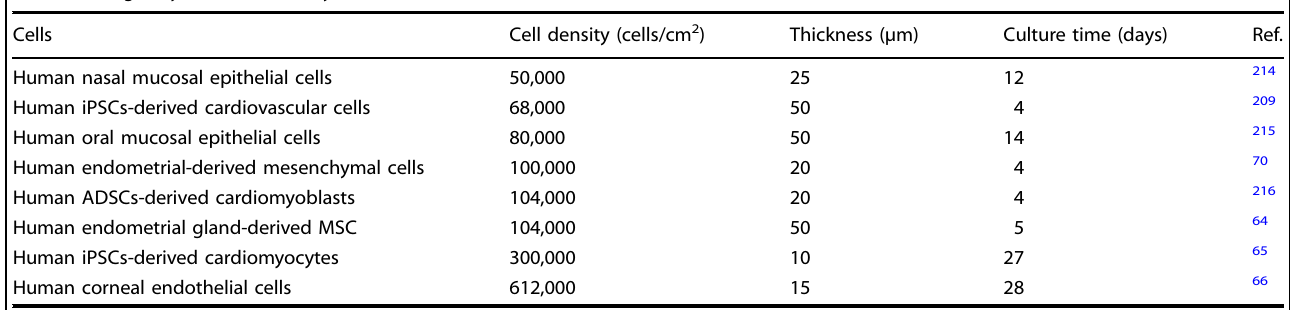
Table 5. Single layer scaffold-free systems derived from human cells. Cells Cell density (cells/cm 2 ) Ref.